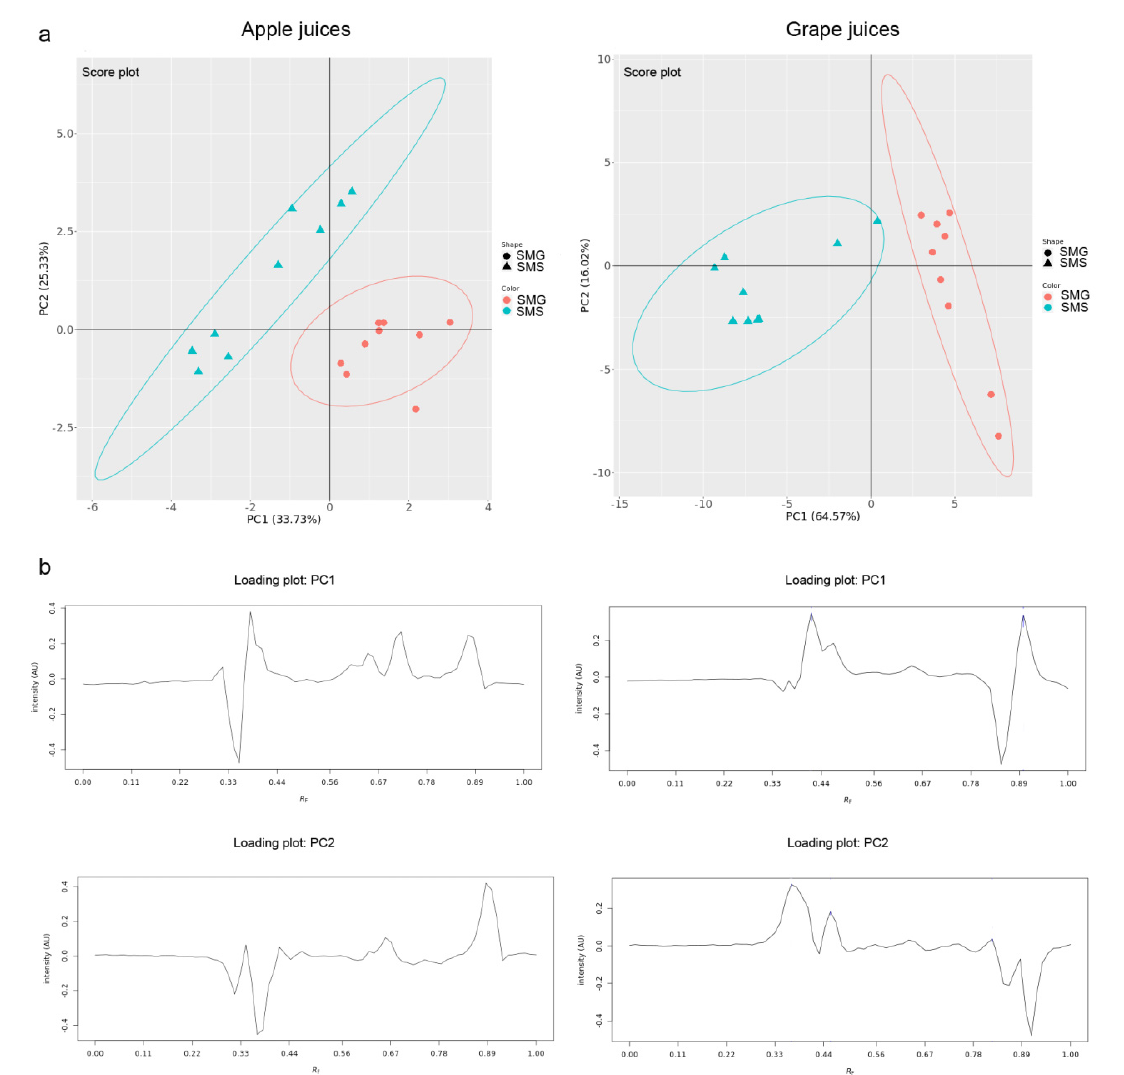
Figure 4. PCA showing the ( a ) PCs score plots and ( b ) PC1 and PC2 loading plots obtained from the HPTLC chromatogram at 366 nm of the extracts of apple and grape juices after derivatization with the natural product A reagent.